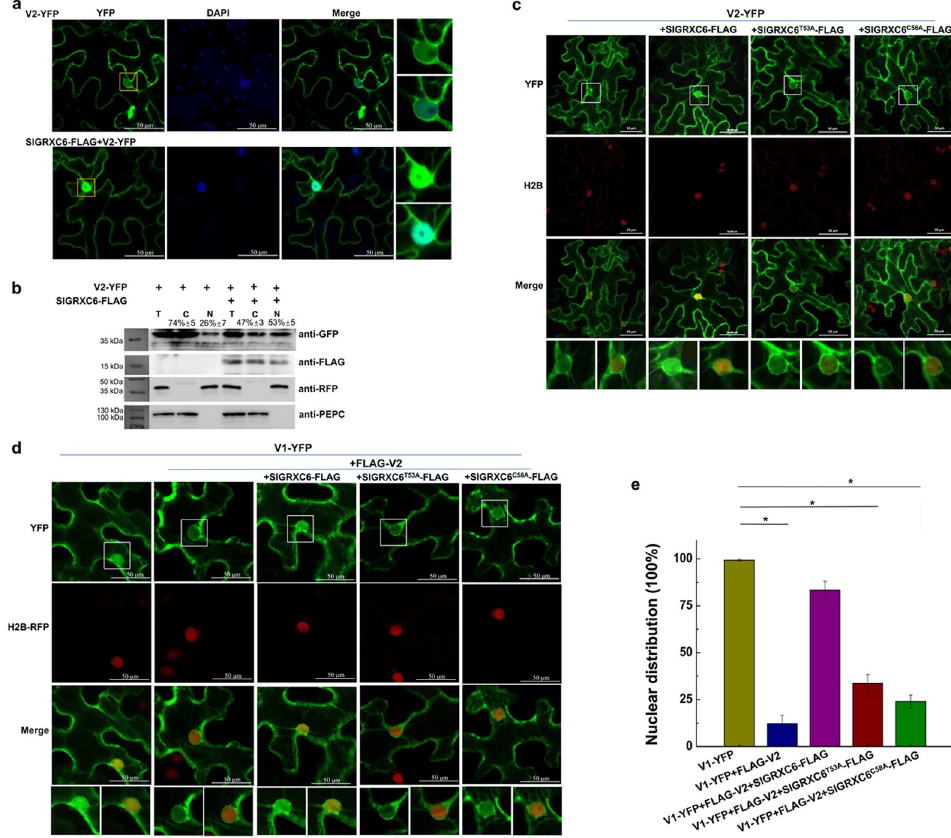
Fig 5. The effect of SlGRXC6 on the nuclear distribution of the V2 and V1 protein. (a) Localization of V2-YFP in the absence or presence of the SlGRXC6 protein in N . benthamiana cells. V2-YFP expressed alone or coexpressed with SlGRXC6-FLAG was detected by confocal microscopy. Experiments were repeated three times and 30 cells were observed in each repeat. DAPI stains DNA in the nucleus. Bars: 50 μ m. (b) The distribution of V2 in the absence or presence of SlGRXC6-FLAG in H2B-RFP transgenic N . benthamiana plants was analyzed using a nuclear-cytoplasmic fractionation assay. Western blotting was conducted with antibodies specific to the indicated proteins. PEPC and H2B-RFP were used as markers for the cytoplasmic and nuclear fraction, respectively. The intensity of the protein signal was measured using ImageQuant TL (GE healthcare), with levels of the cytoplasm and nucleus totaling 100%. Values represent the average of three plants. Experiments were repeated three times. (c) Localization of V2-YFP when expressed alone or in the presence of SlGRXC6, SlGRXC6 T53A , or SlGRXC6 C58A in H2B transgenic N . benthamiana cells. Bars: 50 μ m. Experiments were repeated three times and 30 cells were observed in each repeat. (d) Subcellular localization of V1 was expressed alone or coexpressed with FLAG-V2 and FLAG-tagged SlGRXC6, SlGRXC6 T53A , or SlGRXC6 C58A in H2B transgenic N . benthamiana cells. The H2B-RFP signal represents the nucleus. The enlarged areas show the nuclear region. Bars: 50 μ m. Experiments were repeated three times and 30 cells were observed in each repeat. (e) The number of cells with a nuclear distribution of V1-YFP was counted and the percentage of cells with a nuclear distribution was calculated. Experiments were repeated three times and 30 cells were observed in each repeat. Values represent percentages of cells with nuclear distribution of YFP signal ± SD (standard deviation). Data were analyzed using Student’s t-test and asterisks denote significant differences ( � P <